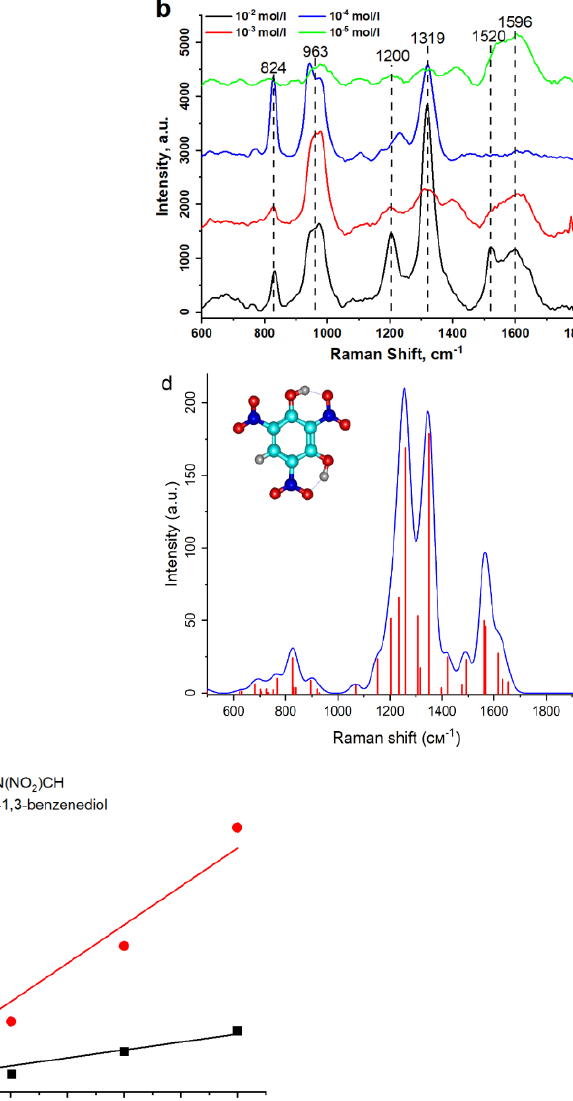
Figure 4. Measured and calculated SERS spectra. ( a ) — measured SERS spectra for (NO 2 ) 3 C 6 H 2 N(NO 2 )CH 3 at concentrations of 10 −2 – 10 −5 M, ( b ) — measured SERS spectra for 2,4,6-trinitro-1,3-benzenediol at concentrations of 10 −2 – 10 −5 M. ( c , d ) — theoretical Raman spectra for (NO 2 ) 3 C 6 H 2 N(NO 2 )CH 3 and 2,4,6-trinitro-1,3-benzenediol, respectively. ( e ) — calibration curves where the averaged peak intensities of the 1317 cm − 1 band was plotted as a function of the logarithmic concentration of (NO 2 )3C 6 H 2 N(NO 2 )CH 3 and the same for the peak intensities of the 1319 cm − 1 band of 2,4,6-trinitro-